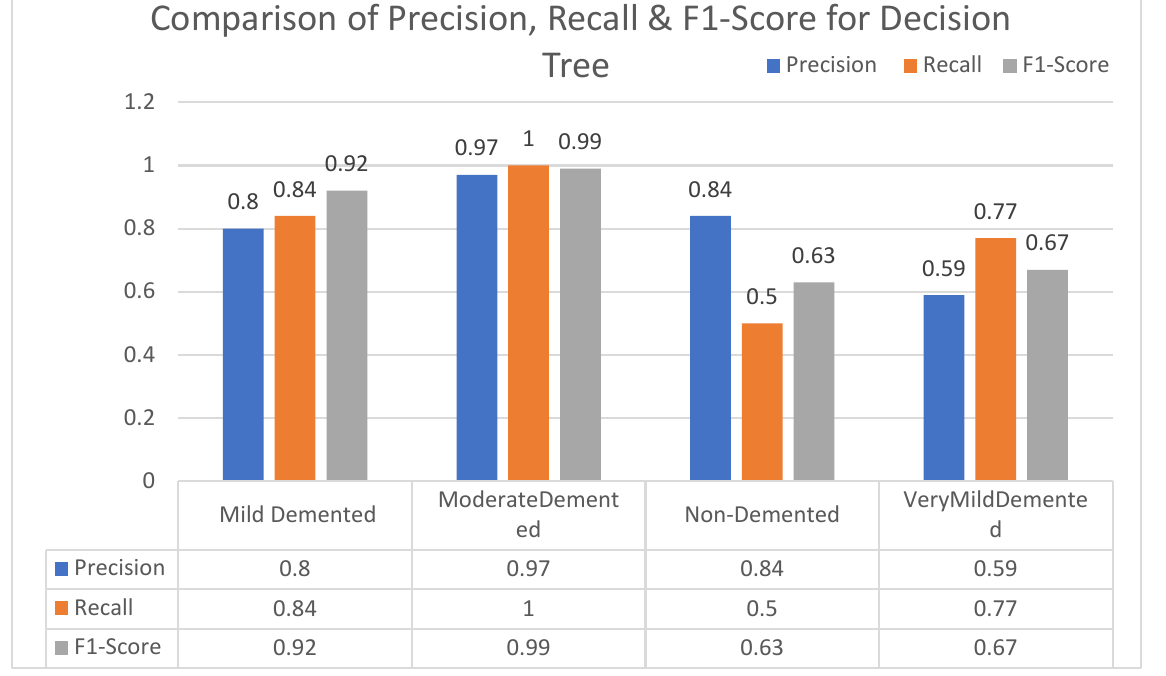
Figure 11. Visualization of Diagnostic Test for Decision Tree.